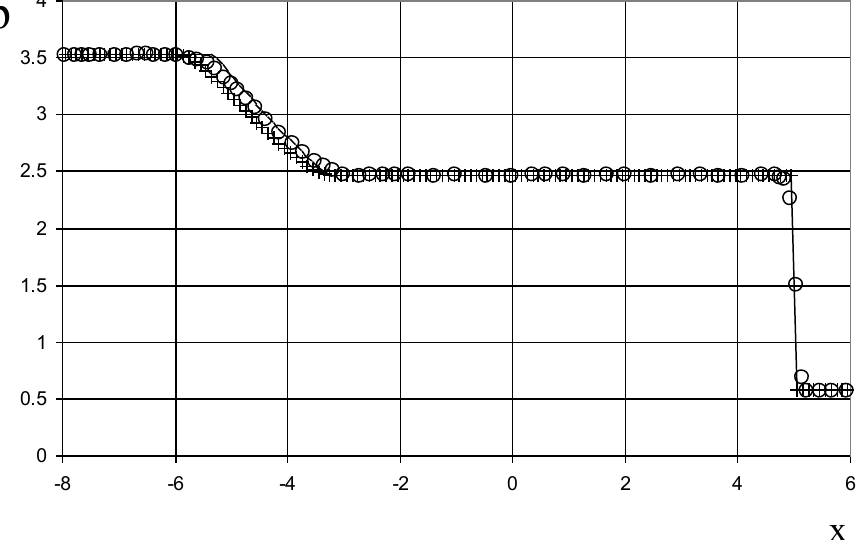
Figure 16. Pressure plot for the Riemann problem of Lax: the exact solution (line), the ULT1C scheme of Harten (circle), and the present method (cross).